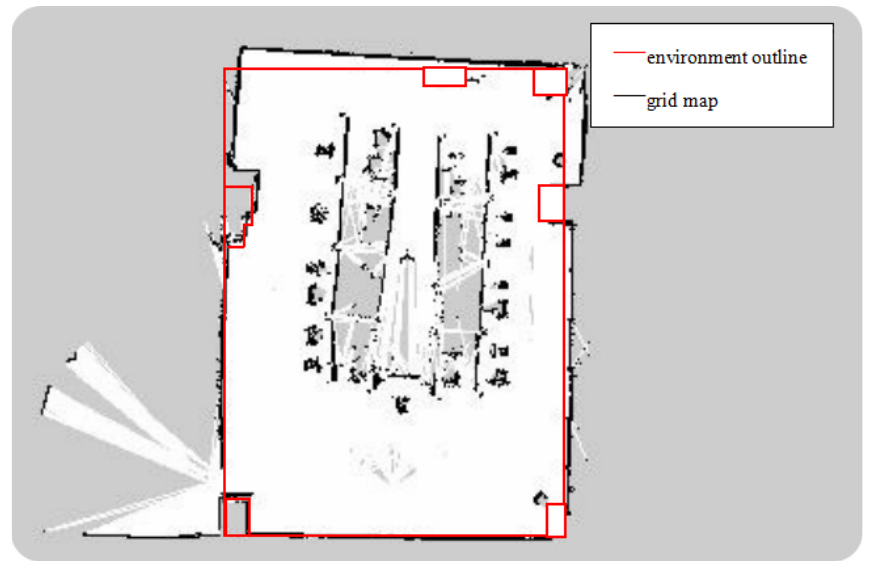
Figure 17. The grid map constructed by traditional Gmapping mapping algorithm in a small indoor environment.